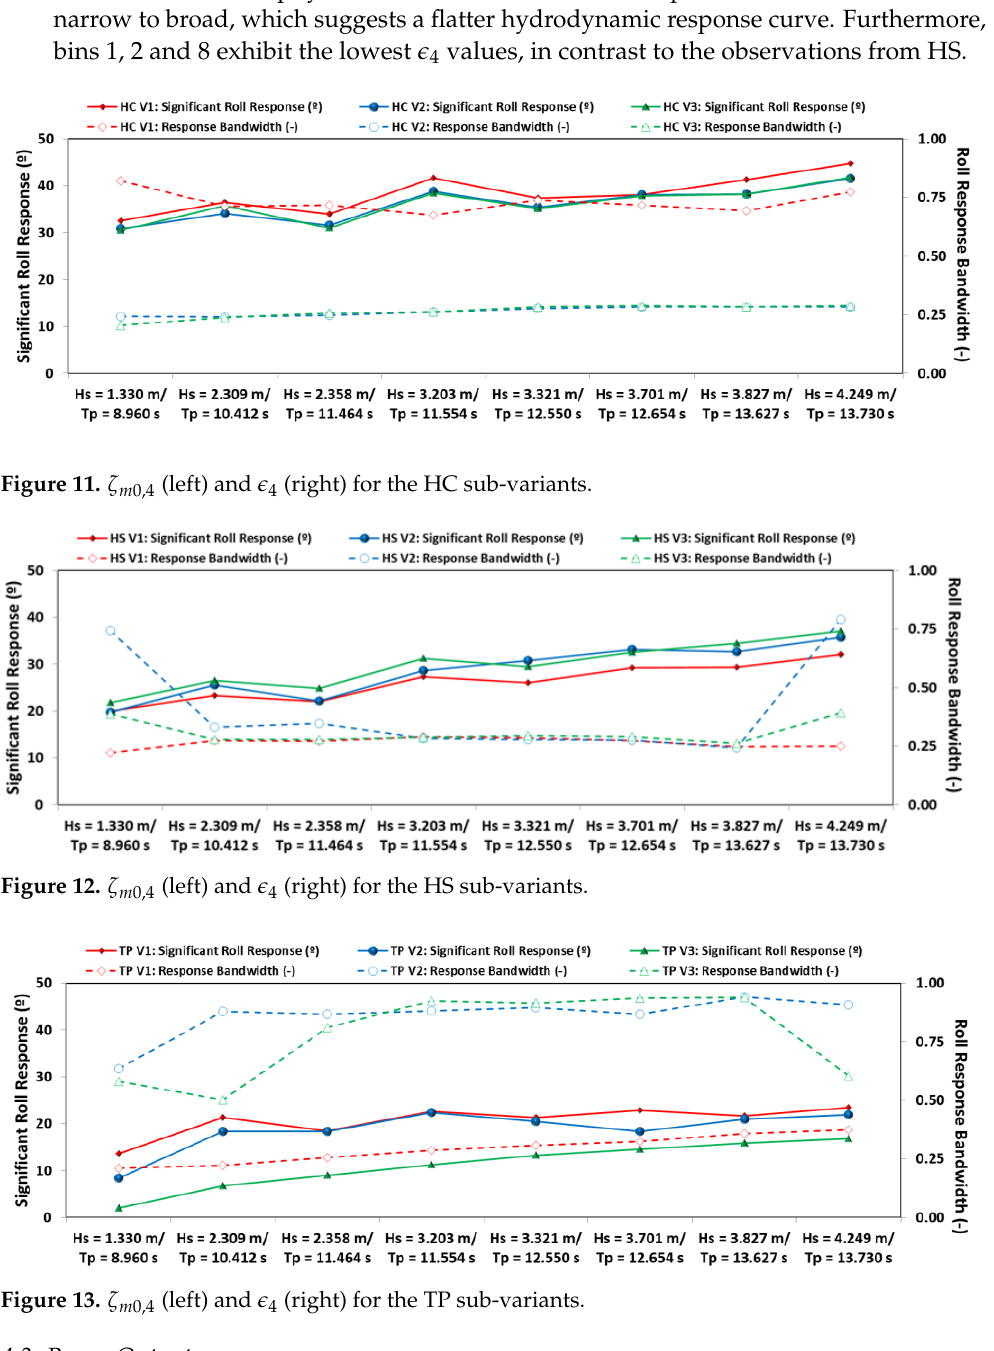
Figure 13. 𝜁 𝑚0,4 (left) and 𝜖 4 (right) for the TP sub-variants.